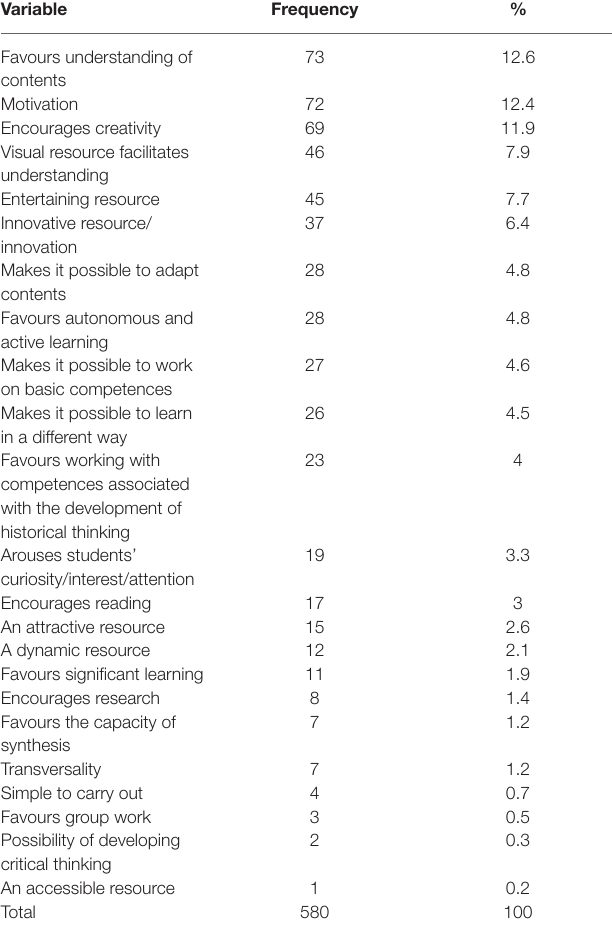
TABLE 9 | Activity has motived me because it has taught me to design my own contents and activities via comics.